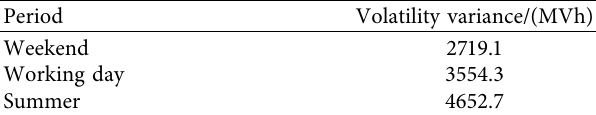
Figure 3: Two-day power load historical data. Table 1: Power load fuctuation